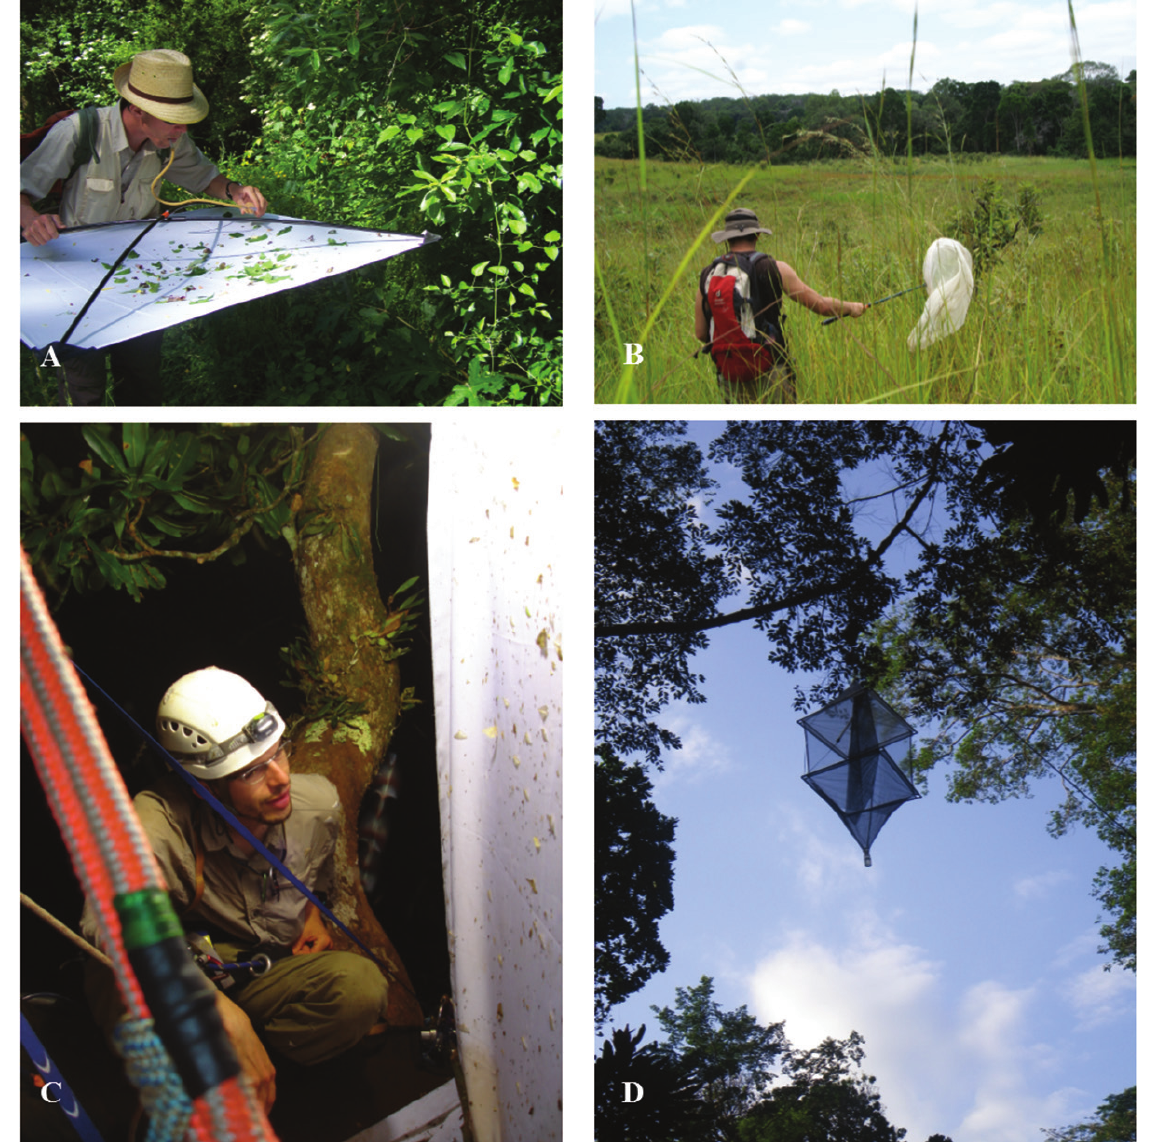
Fig. 2. Illustration of some sampling methods used during surveys in CAR. A. Beating sheet; B. Sweep net; C. Tree climbing; D. Remote Canopy